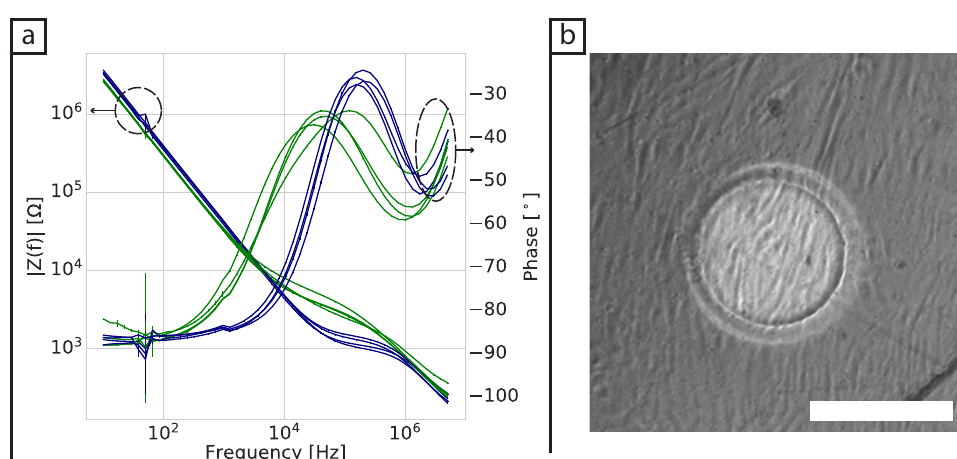
Figure 2. ( a ) Impedance spectra of BJ-5Ta cells seven days after seeding in 2D. Blue lines are from control wells containing DMEM + FBS cell medium, while green lines are from wells containing cells and cell medium. ( b ) Bright field image of a well seeded with cells after seven days of culture. Scale bar = 250 µ